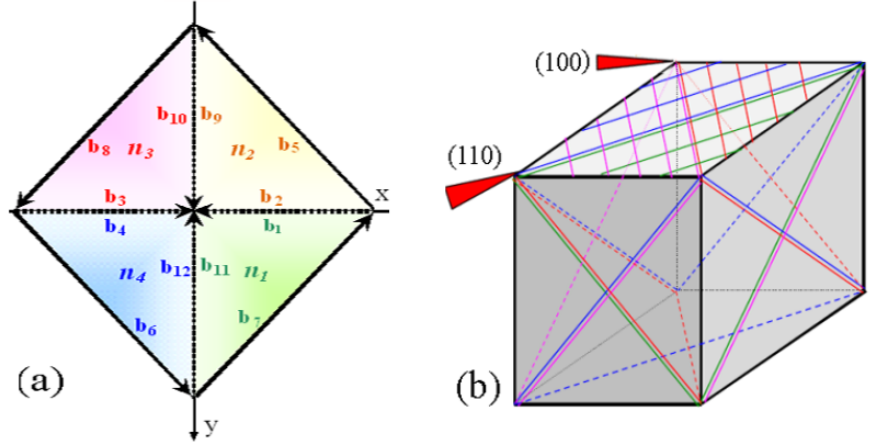
Figure 1. The 12 slip systems in an FCC crystal in ( a ) a top-view along the [001] axis, where n i are the slip planes and b i are the Burgers vectors on each plane. ( b ) The expected intersection lines of the four {111} slip planes with the (001) free surface of the tested crystals are expected to form only two perpendicular traces. The orientation of the two types of cracks is indicated by red triangles.